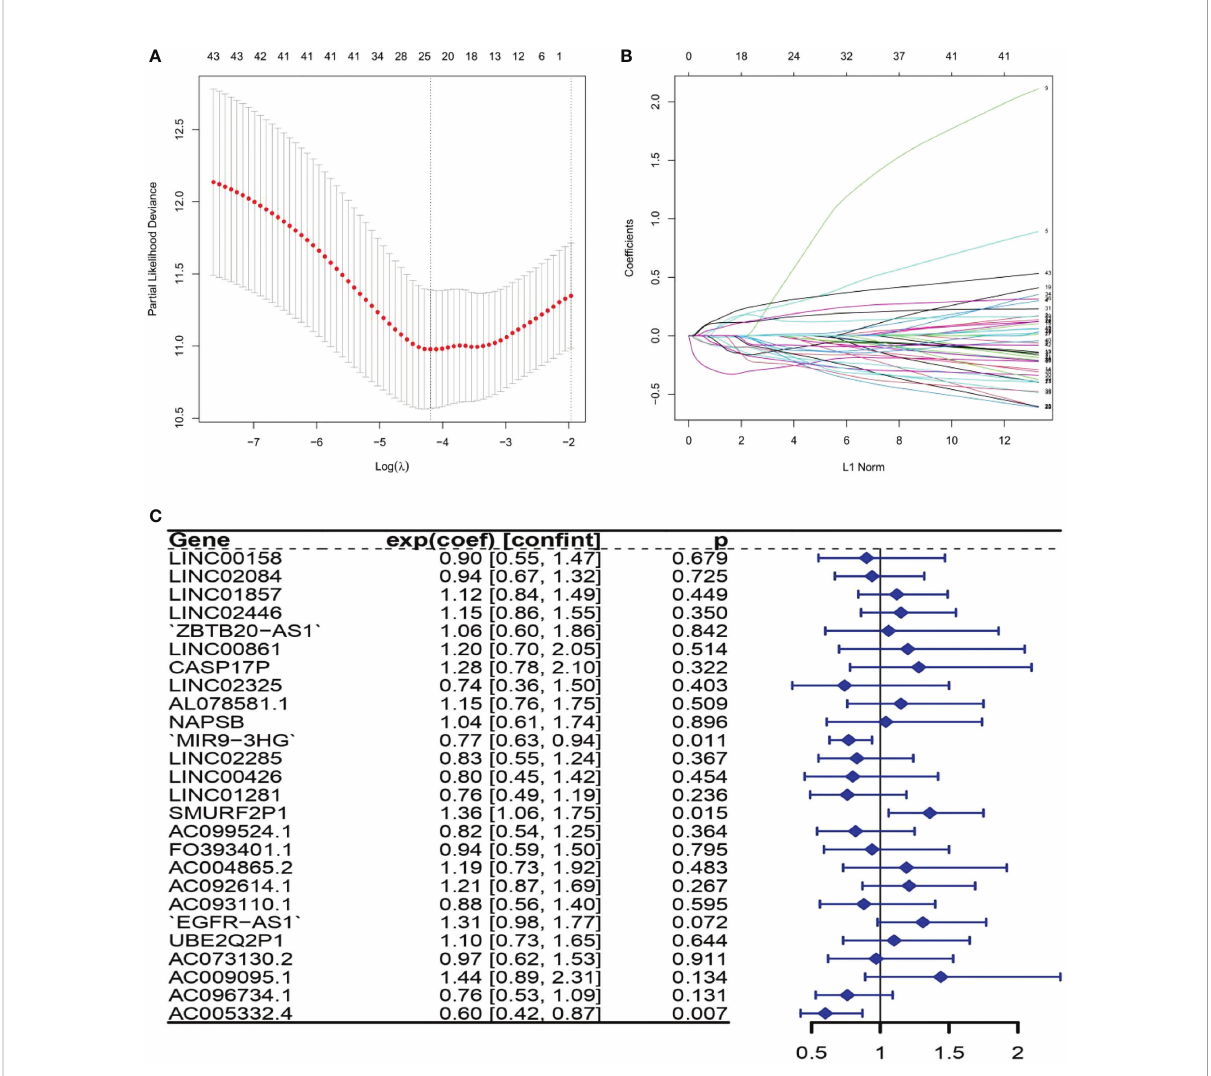
FIGURE 1 The lncRNAs related to autophagy were screened using the least absolute shrinkage and selection operator (LASSO) model: (A) LASSO coef fi cient values for 26 autophagy-related lncRNAs (ARLs) in cervical squamous cell carcinoma and endocervical adenocarcinoma (CSEC). The vertical dashed line is in the optimum log (lambda) value. (B) Overview of LASSO coef fi cients. (C) Forest plots show the results of the association between ARL expression and the Kaplan – Meier estimated total survival probability of CESC samples after the multivariate Cox regression analysis. Values within brackets are 95% con fi dence intervals of the risk